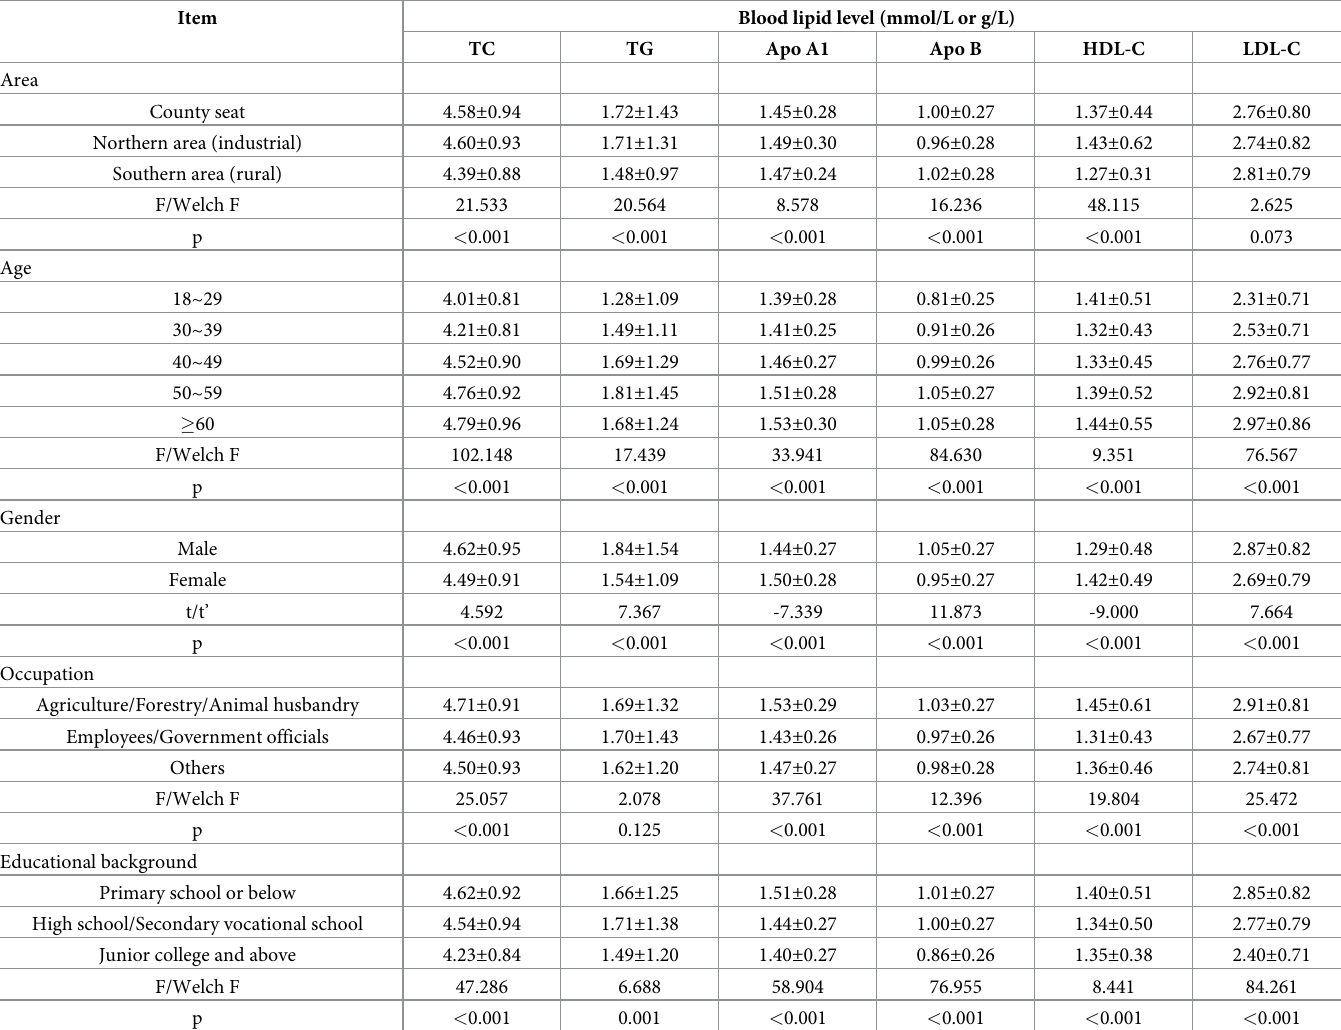
Table 1. Mean value of different blood lipids (Mean ±